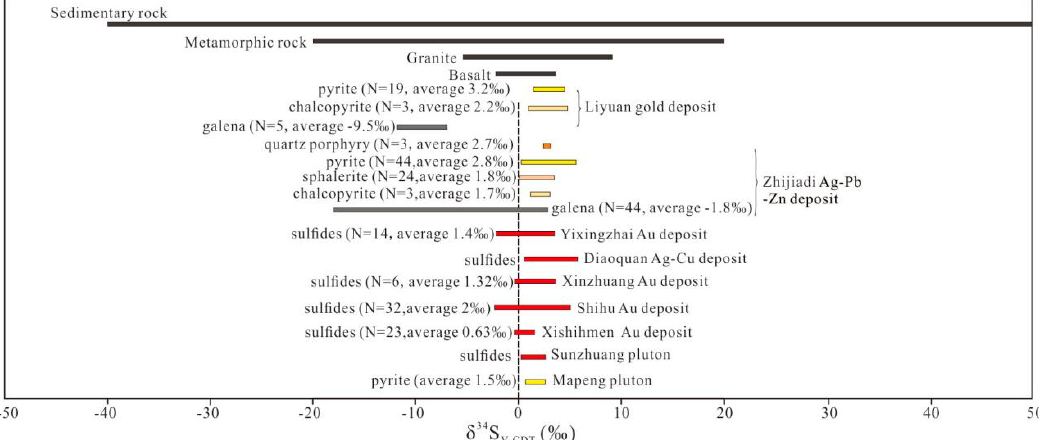
Figure 14. Sulfur isotope composition histograms of sulfide minerals from the plutons and ore deposits in the central Taihang Mountain region (following Reference [84,93]). References: Zhijiadi Ag-Pb-Zn deposit [34]; Yixingzhai gold deposit [36]; Diaoquan Ag-Cu deposit [88]; Xinzhuang gold